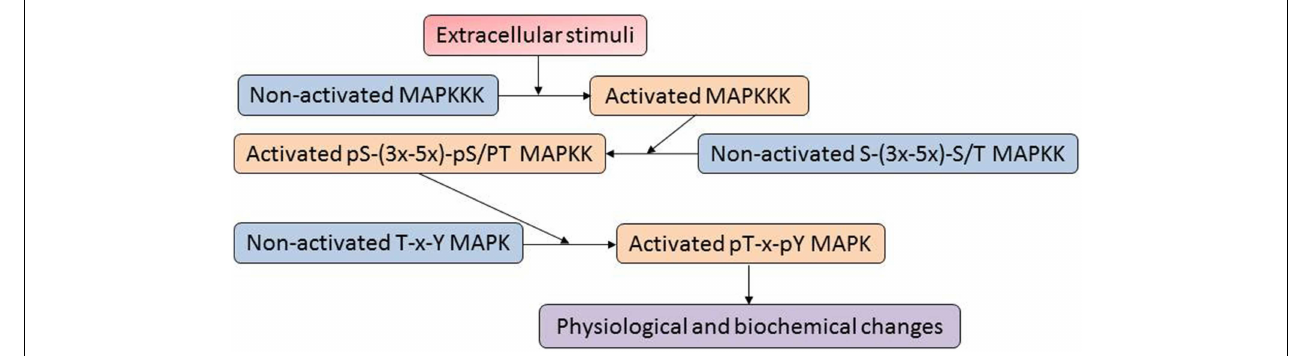
FIGURE 1 | A typical mitogen-activated proteins (MAP) kinase cascade. The MAPK cascades are generally organized as modular pathways, in which the activation of upstream MAPKKKs leads to the sequential phosphorylation and subsequent activation of downstream MAPKKs and MAPKs.